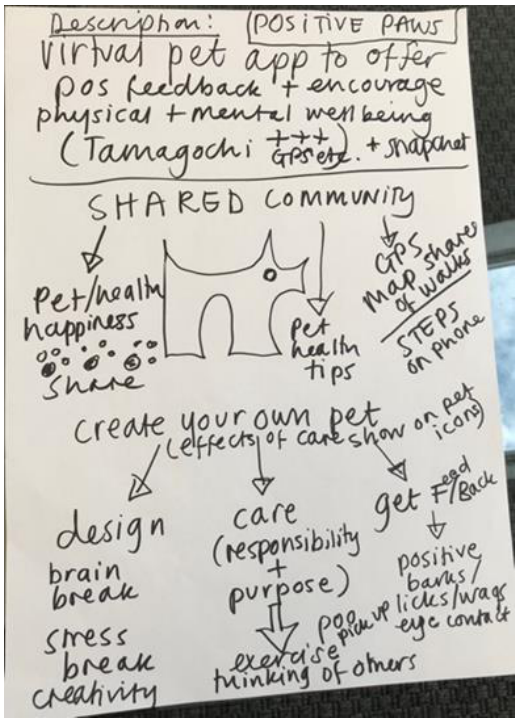
Figure 1. Group idea during expert workshop